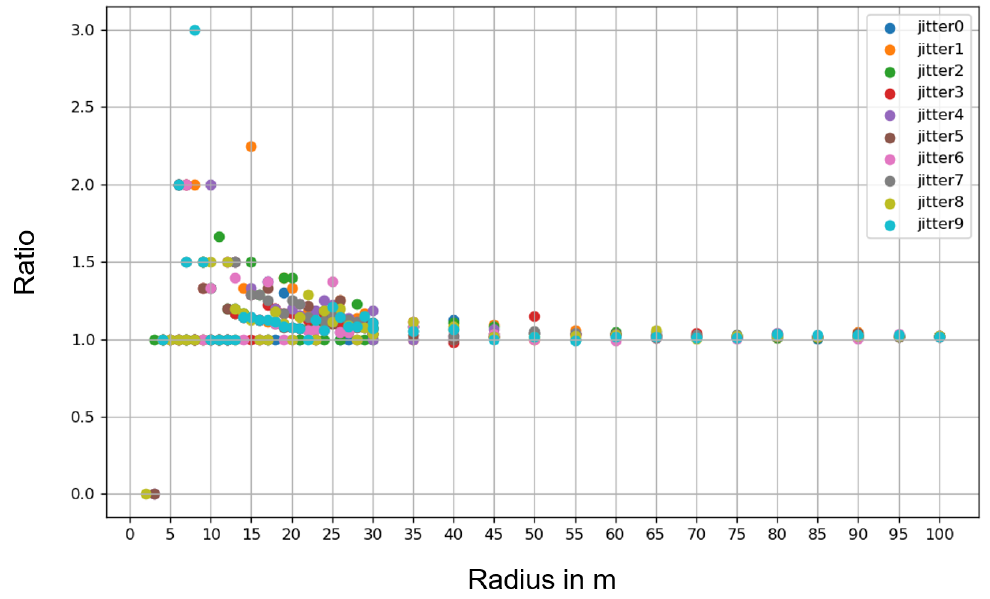
Figure 10. Ratio of the number of plastic pixels detected on the number of plastic pixels simulated depending on the radius of the patch and for 10 different jitters.